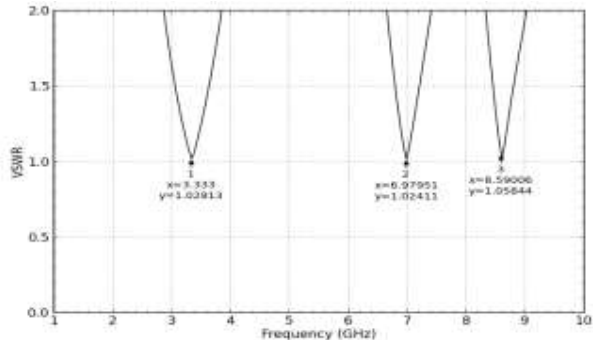
Figure 11: Simulated VSWR versus frequency graph of the proposed antenna